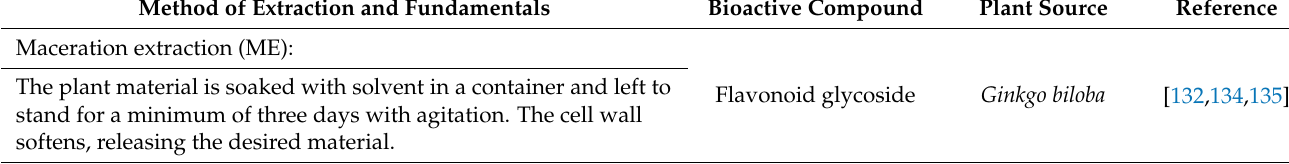
Table 2. Extraction techniques for the obtaining of bioactive compounds from